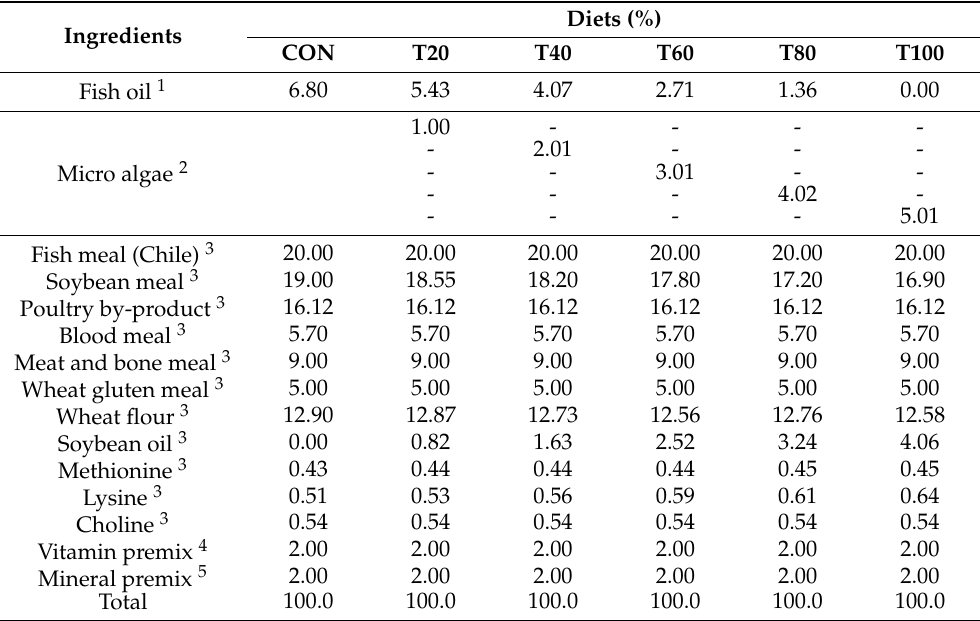
Table 2. Ingredient composition of the experimental diets fed to rainbow trout juveniles over an eight-week growth trial (% of DM